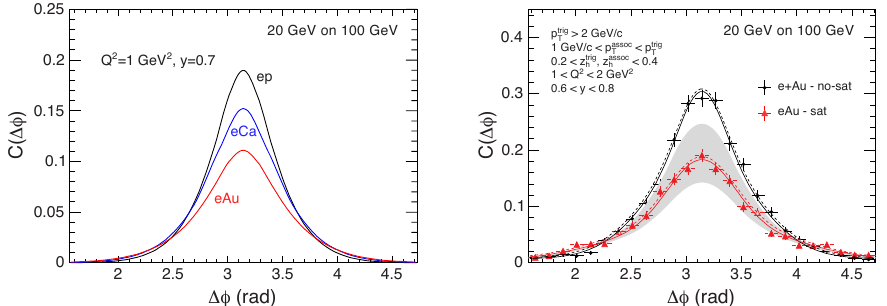
Figure 31. ( Left ) Dihadron correlation function in electron collisions with different nuclei showing a depletion of the back-to-back peak. ( Right ) Comparison of the correlation function with and without saturation. The gray band is a result of varying the saturation scale. Figure from the work in